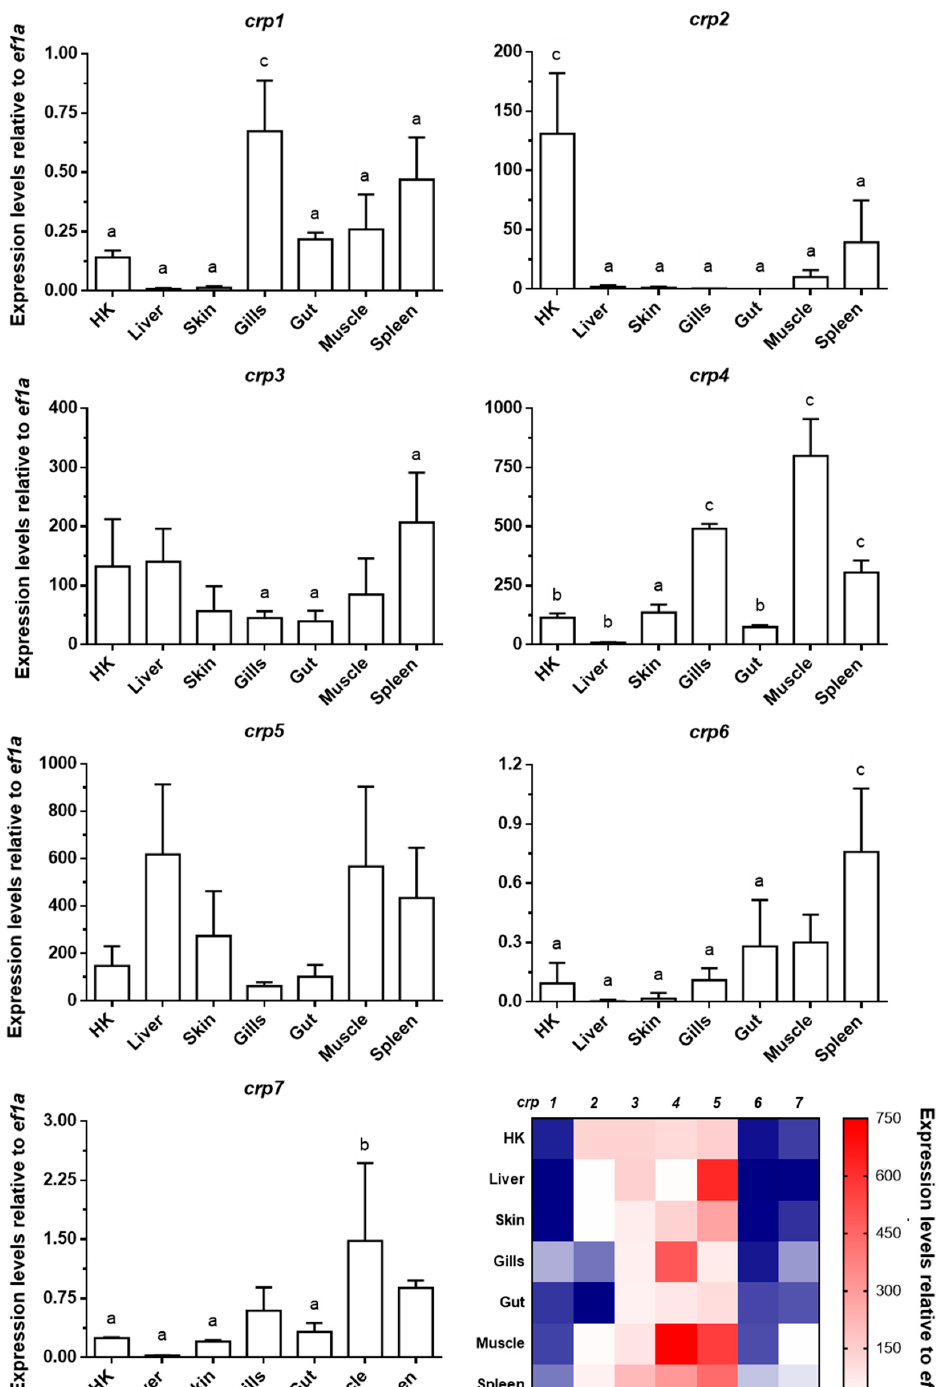
Figure 1. Gene expression analysis of crp1–7 in tissues of healthy zebrafish. The expression of crp1 – 7 was determined by RT-qPCR by using specific primers for each isoform (Table S1). ef1a mRNA was used as the endogenous control to normalize data, which are represented as the mean relative expression level × 10 3 ± SD of four different individuals. Statistical differences ( p < 0.05, one-way ANOVA) between tissues are represented by: a (different from up to 1–2 tissues), b (different from up to 3–4 tissues), and c (different from up to 5–6 tissues). Data in bar graphs are summarized in a final double gradient colormap (descending blue gradient for values from 0 to 1 and ascending red gradient from values from 1 to ≥